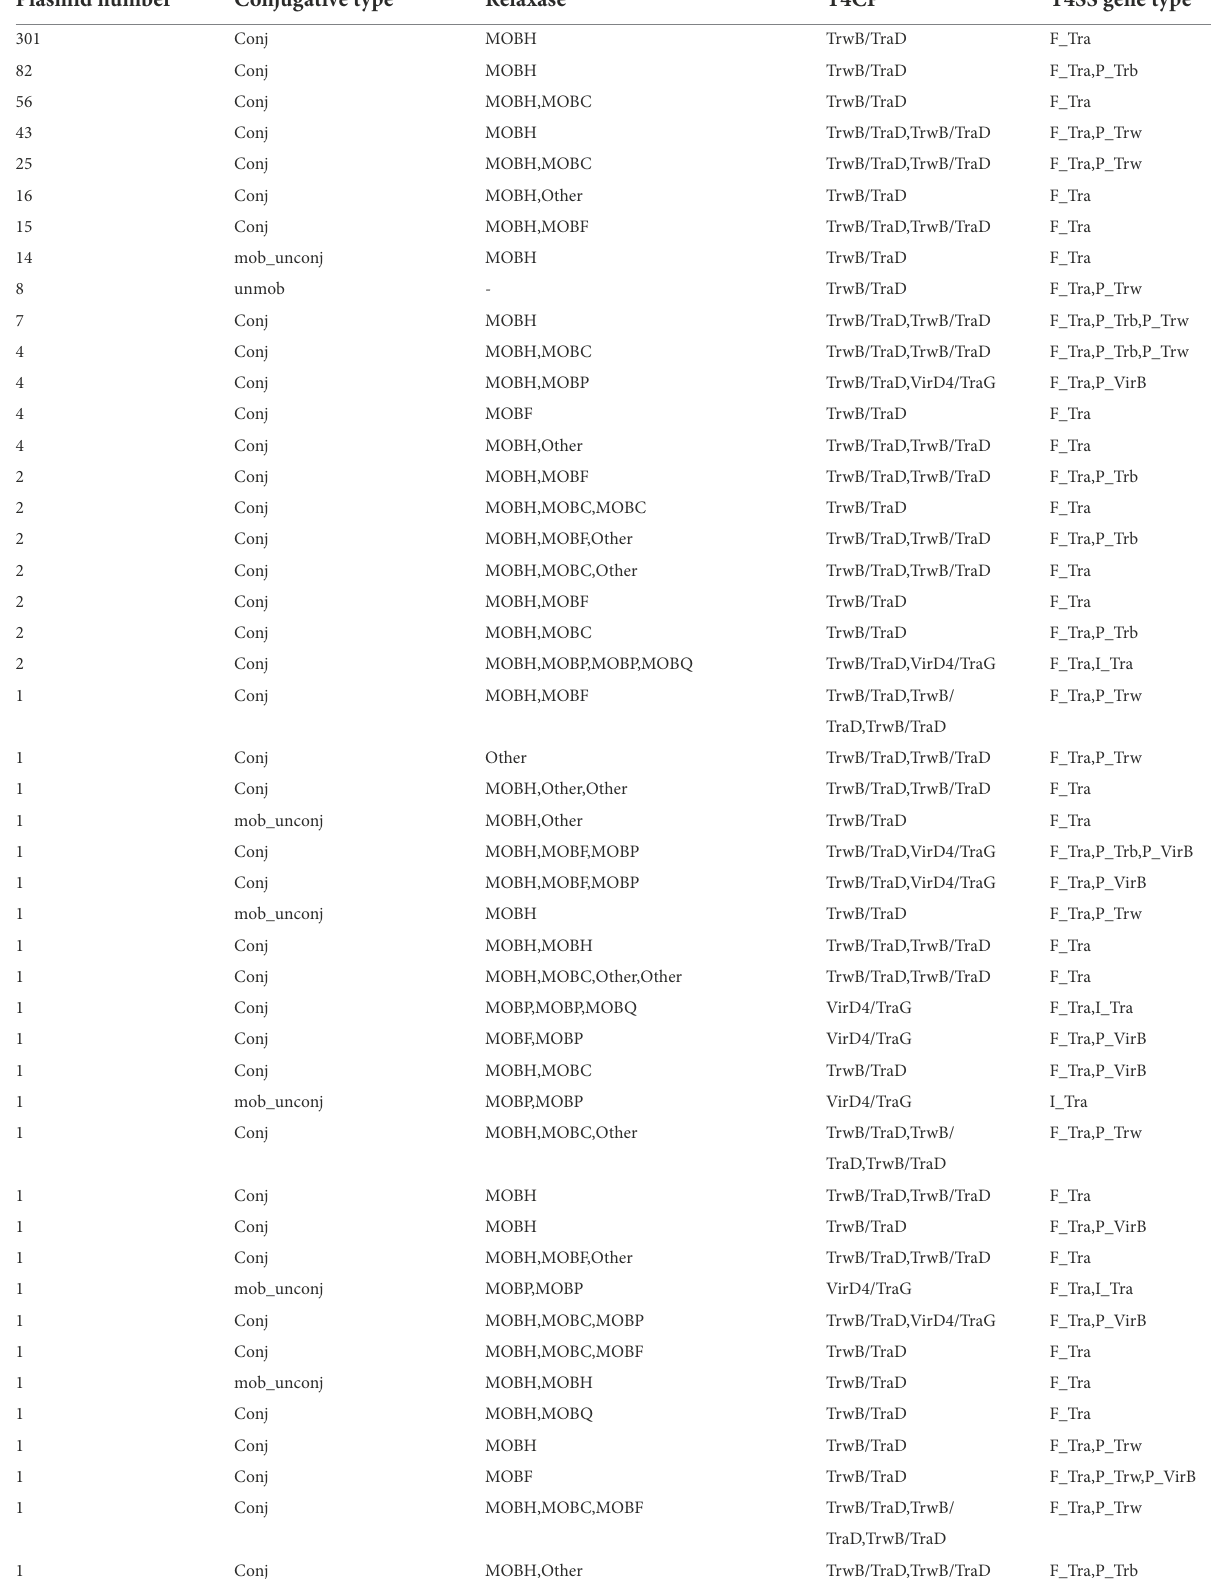
TABLE 1 The types of conjugative transfer system components of plasmids containing T4CP. Plasmid number